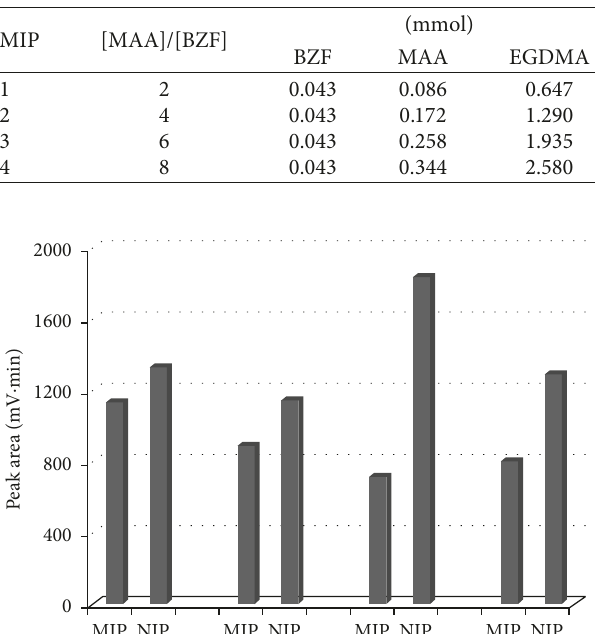
5 M. 3.50 10 (cid:30) × −